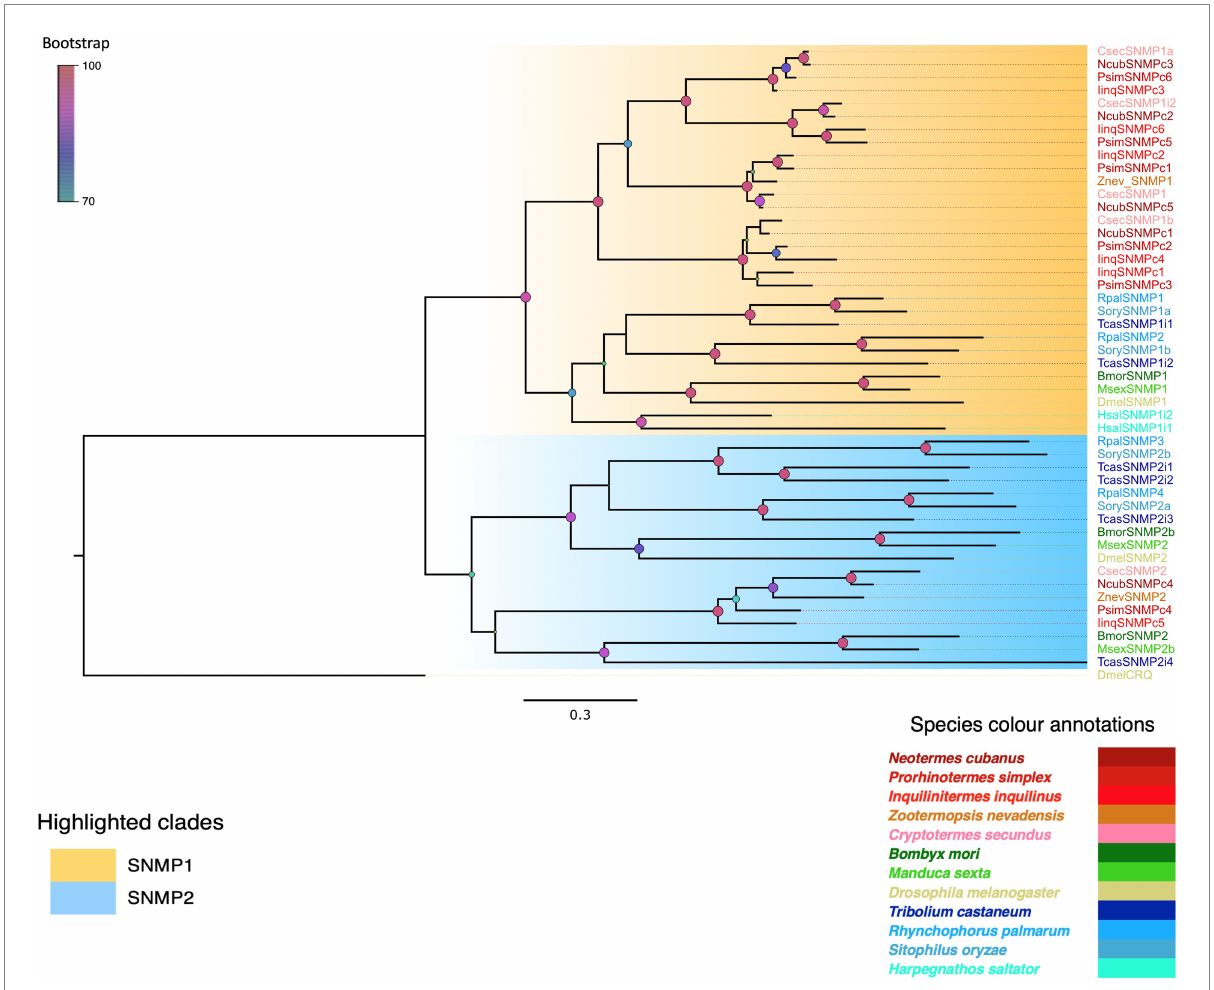
FIGURE 4 Maximum likelihood phylogenetic tree indicating two SNMP types in termites. The tree was constructed using LG + R as the best-fit amino acid substitution model under Bayesian information criterion. The two SNMP types are highlighted as SNMP1 (orange) and SNMP2 (blue). Species abbreviations used are C. secundus (Csec), N. cubanus (Ncub), P. simplex (Psim), I. inquilinus (Iinq), Z. nevadensis (Znev), D. melanogaster (Dmel), S. oryzae (Sory), T. castaneum (Tcas), R. palmarum (Rpal), B. mori (Bmor) M. sexta (Msex), and H. saltator (Hsal). Sequence names are colored according to species and color codes are provided in the in-figure legend. The node colors indicate the bootstrap support (1,000 replicates). The scale bar represents the estimated amino acid substitutions per